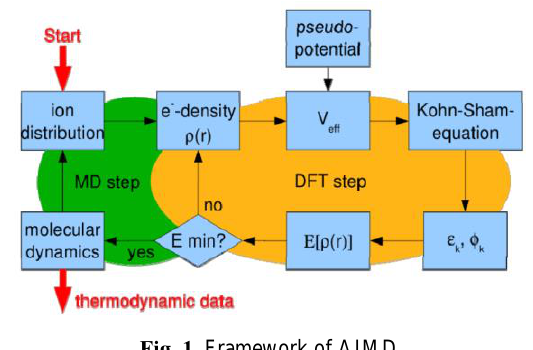
Fig. 1. Framework of